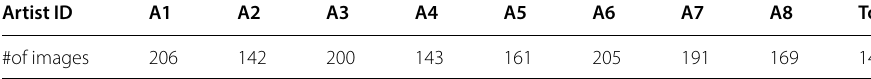
Table 2 Number of panel images in each class for the experiments